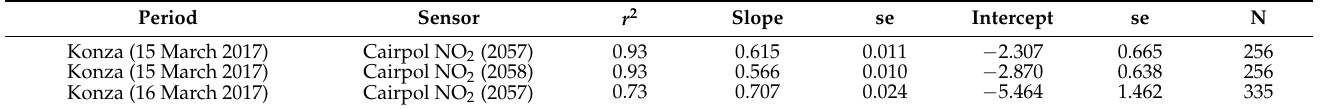
Table A5. Regression statistics for NO 2 sensors versus reference